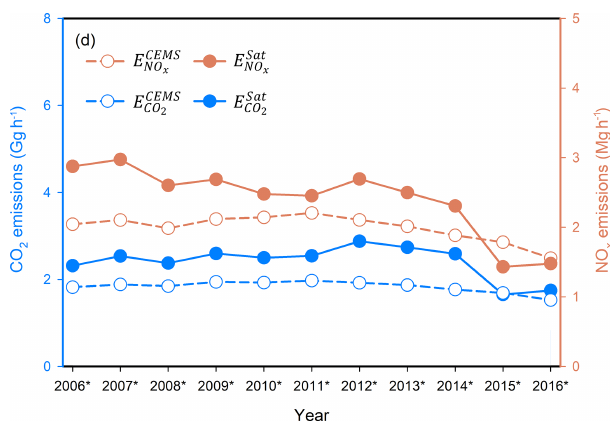
Figure 3. E Sat (Mgh − 1 ; orange solid line, right axis) and E Sat NO x CO 2 (Ggh − 1 ; blue solid line, left axis) for the Rockport power plant from 2005 to 2017. E CEMS and E CEMS (dashed lines) are also NO x CO 2 shown. The 3-year periods are represented by the middle year with an asterisk (e.g., 2006 ∗ denotes the period from 2005 to